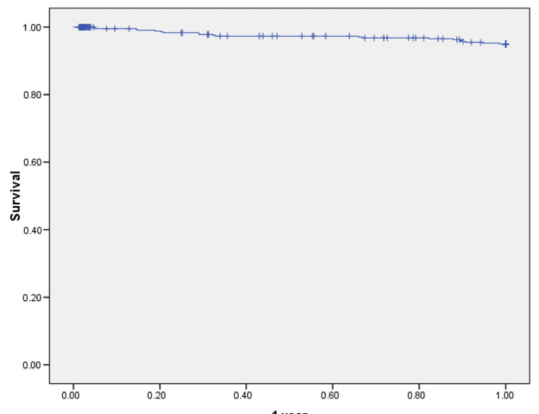
Figure 1. Overall 1-year survival of patients undergoing hand-assisted laparoscopic surgery for cancer (all